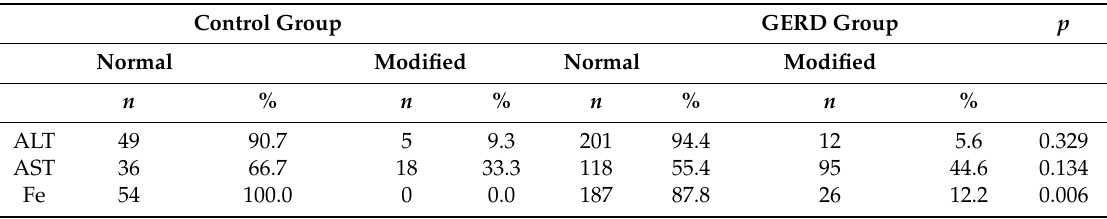
Table 3. Comparative study of ratios regarding patients with modified liver enzymes in the GERD group and the control